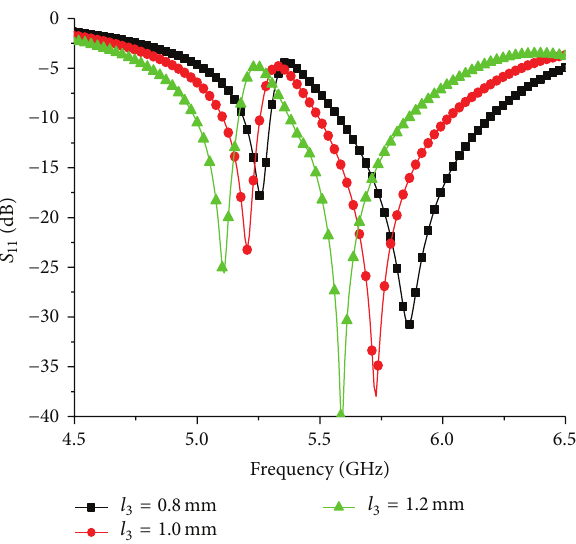
Figure 5: Simulated |𝑆 11 | for antenna operating at various 𝑙 3 .